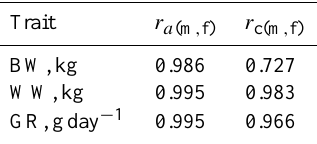
Table 7. Correlations between random effects estimated in different sexes.